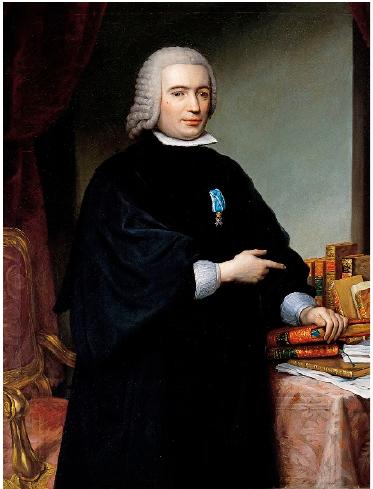
Figure 1. Portrait, by Antonio Carnicero, of Pedro Rodríguez de Campomanes y Pérez-Sorriba, first Count of Campomanes (Santa Eulalia de Sorriba, Tineo, Asturias, 1 July 1723—Madrid, 3 February 1802), who was a Spanish politician, jurisconsult and economist. He was appointed Minister of Finance in 1760 in the first reformist government of Carlos III’s reign, which was led by the Prime Minister Count of Floridablanca, and he was stripped of his position due to the fear that the French Revolution aroused in King Charles IV in 1789. Source: Wikipedia Commons.